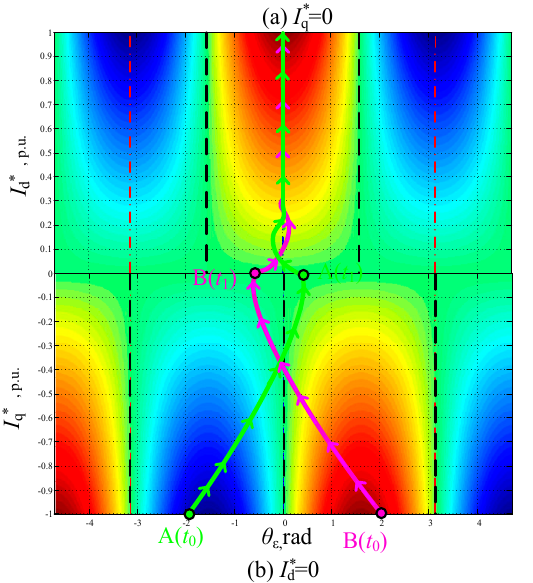
Figure 8. Heat map of the reactive current reference of strategy 2: I ∗ to 0. Based on (14), the boundaries’ expressions of positive and negative active power of strategy 2’s first stage ( t 0 < t < t 1 ) and second stage ( t > t 1 ) in Figure 8 are as